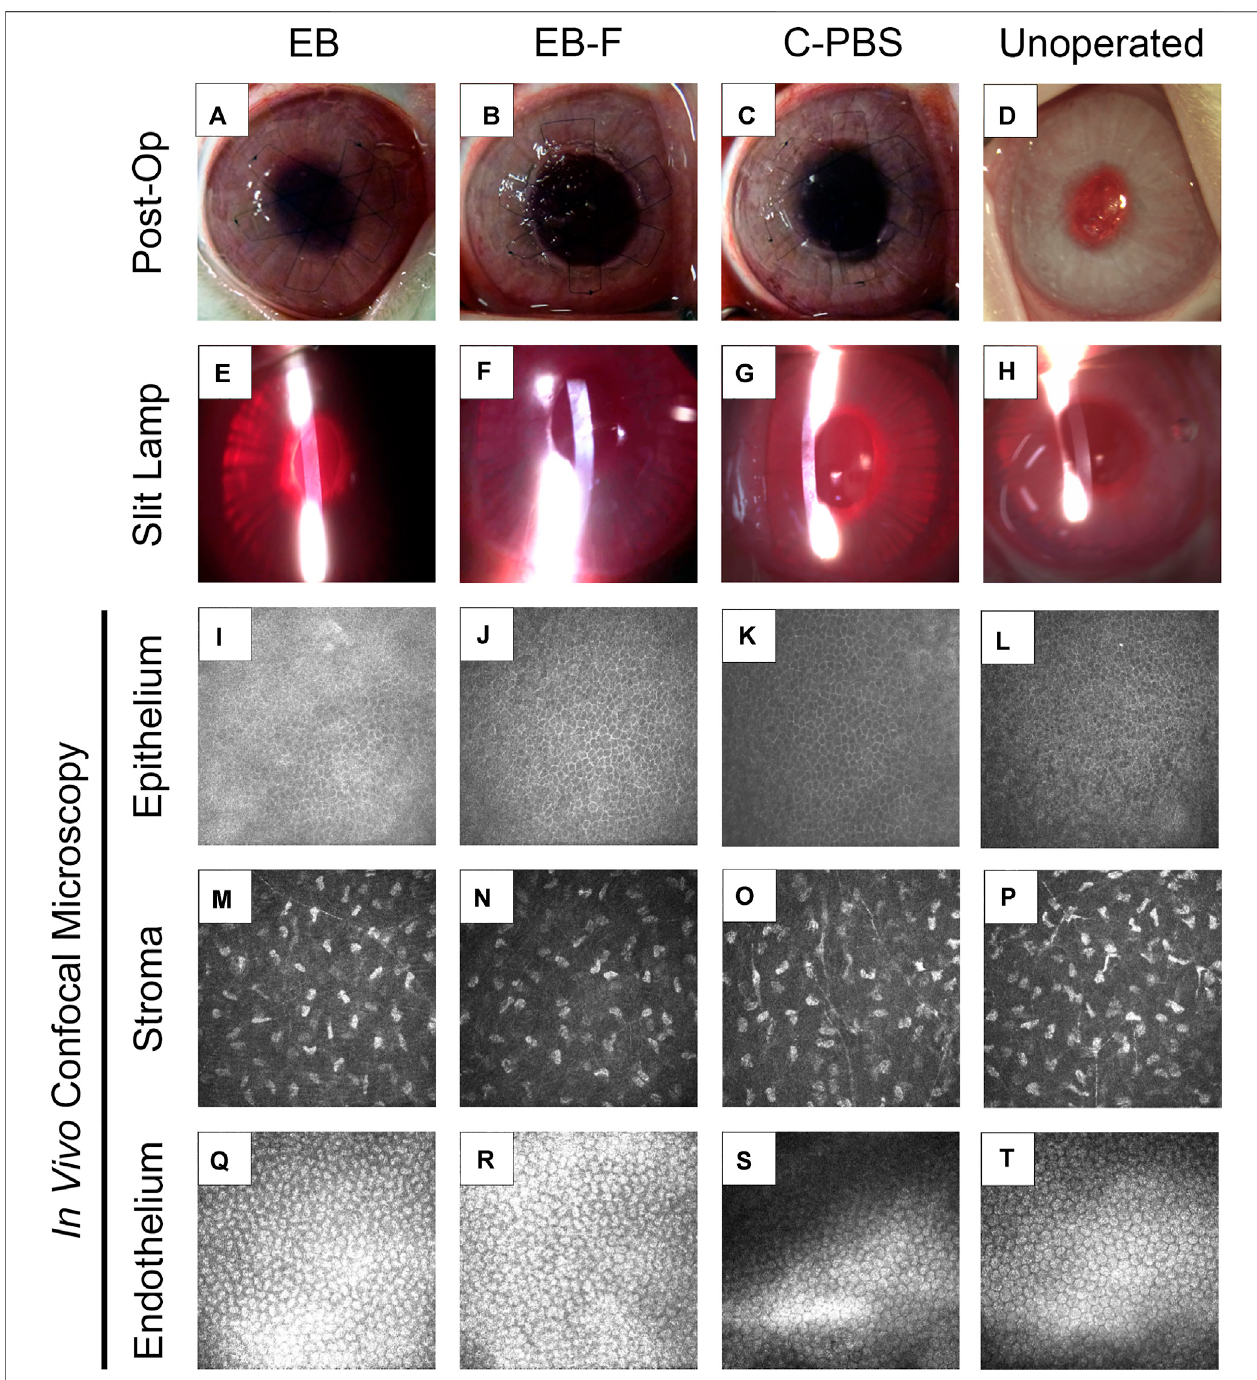
FIGURE 2| RHCIII-MPC implants that had been sterilized with e-beamat 17 kGy irradiation in phosphate-buffered saline ( n =4) (A,E,I) , irradiated and then stored frozenat − 80 ° Cafterwithdrawalofsaline( n =4) (B,F,J) orinphosphatebufferedsaline(PBS)containing1%chloroform( n =4) (C,G,K) aftergraftingintorabbitcorneasin comparison to unoperated eyes ( n = 12) (D,H,L) . Slit lamp images at 6 months post-operation (E – H) and corresponding in vivo confocal microscopy (IVCM) images at these times (I – T) . The IVCM images show the regenerated epithelium (I – L) and stroma (M – P) , as well as healthy endothelium beneath the implant area (Q – T) . Unoperated ( n = 12), unirradiated ( n = 4), and irradiated ( n = 4).